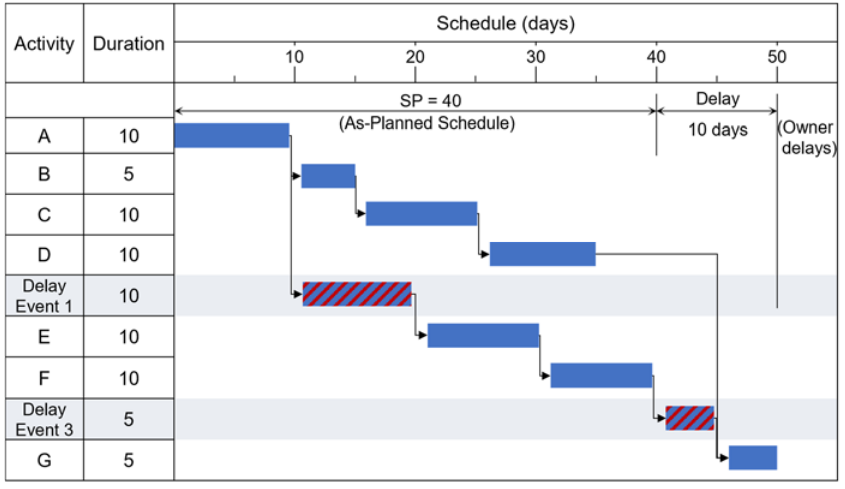
Figure 12. Owner ‐ caused delay. Figure 12. Owner-caused delay.